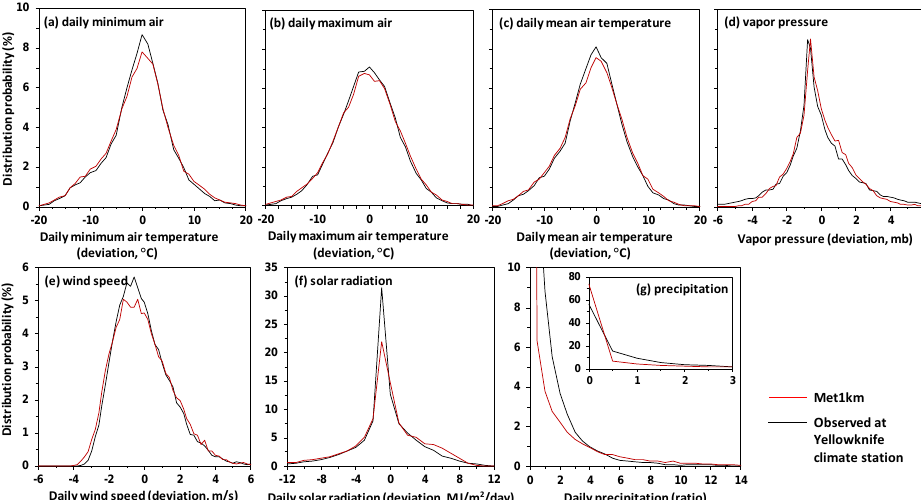
Figure 8. Comparisons of the probability distributions of Met1km data with that of the observations at the Yellowknife airport climate station. The x-axis is expressed as ( a – f ) deviations from or ( g ) ratio to the long-term average seasonal pattern, which is interpolated from long-term monthly averages. The inset in panel ( g ) shows the same data but in different scales. The daily data are from 1948 to 2016 for precipitation and from 1953 to 2005 for other climate variables.